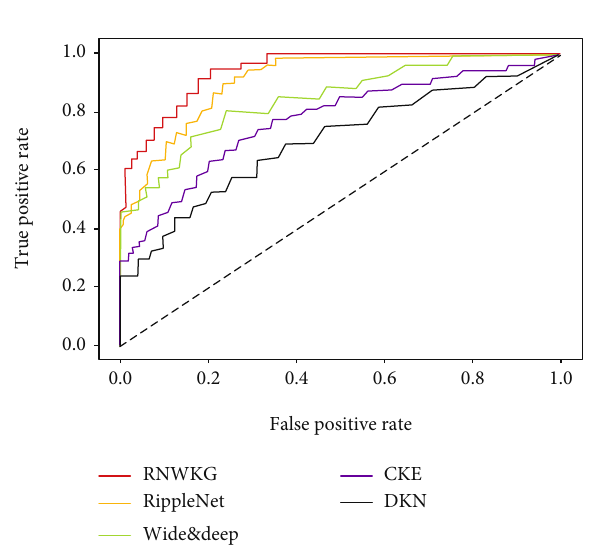
Figure 6: Comparison of ROC curves of fi ve models in MovieLens-